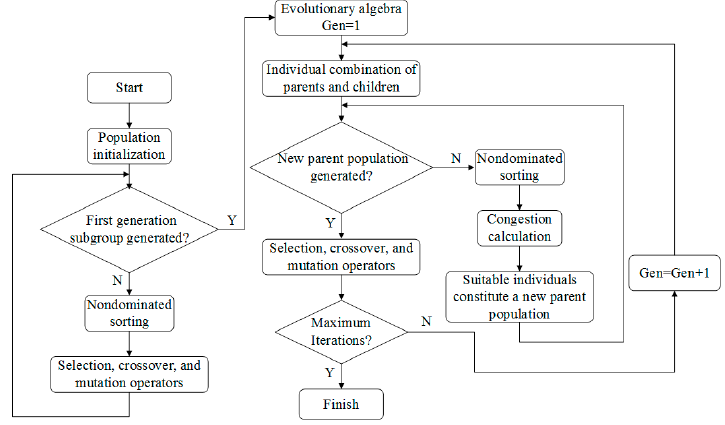
( b ) Figure 9. Temperature prediction. ( a ) Comparison of experimental and predicted value, ( b ) R − elative error. 5. Cu tt ing Parameter Optimization Based on NSGA-II Algorithm